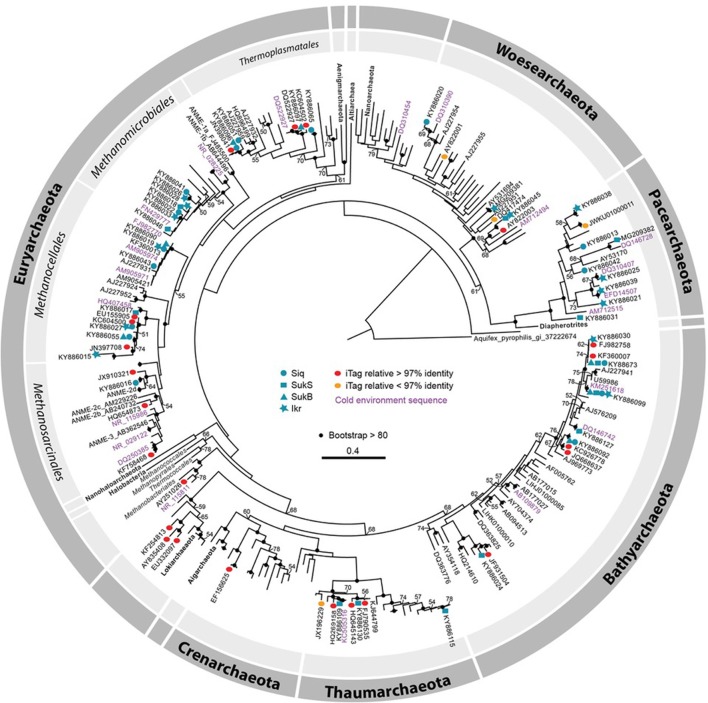
Maximum likelihood phylogenetic tree of SSU rRNA gene (626–660 bp). Clone library sequences from both years (2010 and 2011) are coded by symbol as follows: Siq—circles, SukB—hexagons, SukS—squares, and Ikroavik (Ikr)—stars, followed by their corresponding accession numbers. Note that only one representative sequence was included for each taxon in the phylogenetic tree, and all the other sequences are available (KY886013–KY886132). Silva database sequences with ≥97% identity to iTag sequences are shown as red ovals and sequences with ≤97% identity are shown as orange ovals. Environmental sequences or culture isolates in the GenBank that were ≥97% similar to Sanger sequences, and that were obtained from cold environments (e.g., Canadian Arctic, Laptev Sea, Alaska, Antarctica, and others) are represented in pink and nearest neighboring sequences obtained in GenBank or the SILVA database are in purple. Only bootstrap values ≥50 are shown, and bootstrap values ≥80% are represented by black circles. For a full description of the SSU rRNA gene sequences on the tree, including sequences from the JGI IMG database, see Figure S4.